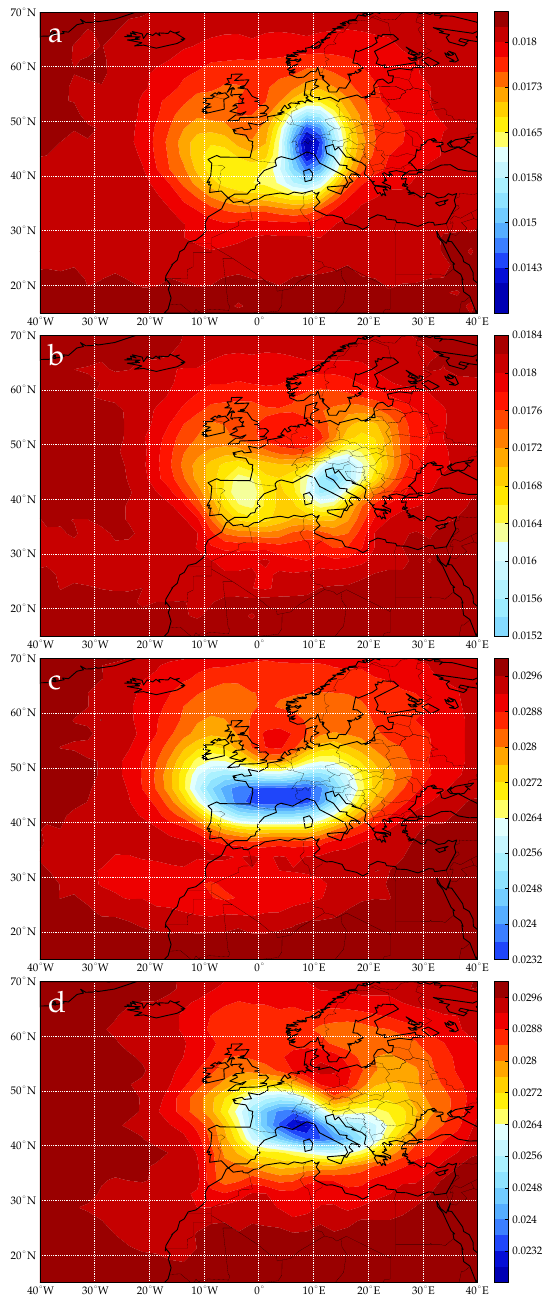
Fig. 4. Relevance map (a) on the 500hPa at 1t = 0h and (b) on the 1000hPa at 1t = − 6h for the Binn station, and (c) on the 500hPa at 1t = 0h and (d) on the 1000hPa at 1t =+ 6h for the Mar´ecottes station. The values are the CRPS